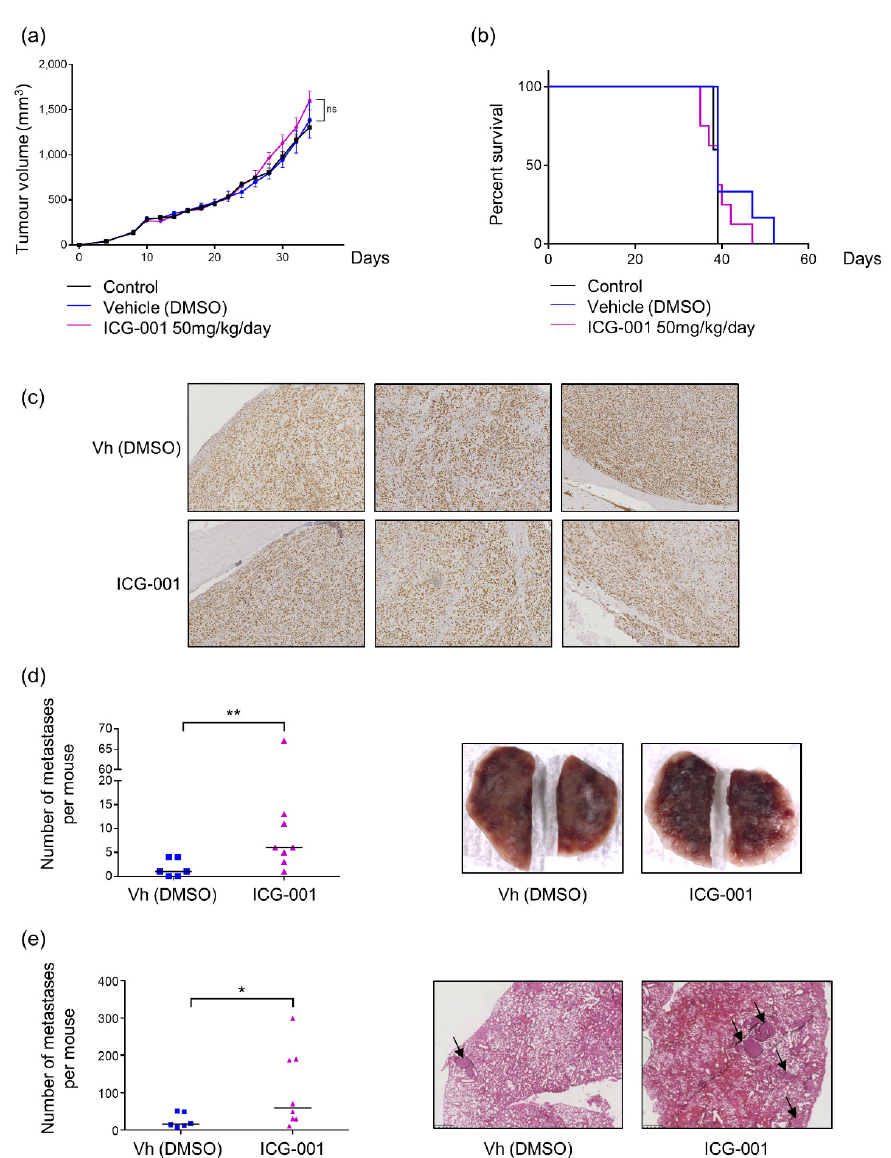
Figure 6. ICG-001 enhances metastatic dissemination to lungs in a mouse model of osteosarcoma. ( a ) Tumor growth monitoring by volume measurement every two days. Different curves (Control n = 5, DMSO n = 6, ICG-001 50 mg/kg/day n = 8) represent means ± SEM. ( b ) Survival curves, with a median survival of 39 days for each group. ( c ) Representative images of paratibial tumor sections slides from DMSO or ICG-001 mice groups stained with Ki67. Magnification × 20. ( d ) Macroscopic count of metastases, each dot represents the number of metastases per mouse, and bars represent medians. ** p ≤ 0.01. ( e ) Histological count of metastases after Hematoxylin-Eosin staining, each dot represents the number of metastases per mouse, bars represent medians. On the right panel, arrows indicate metastases * p ≤ 0.05.